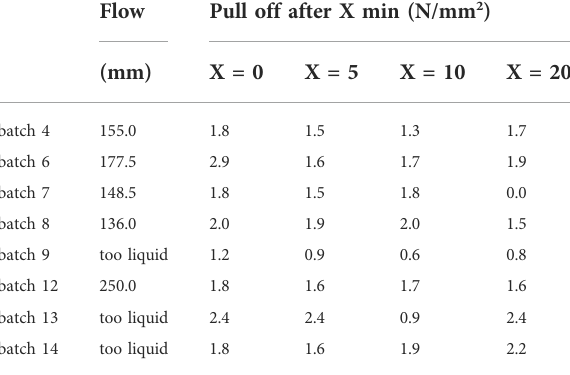
TABLE 4 Results of the consistency test ( fl ow) and the pull-off strengths of test {B} after curing for 3 days to determine the open